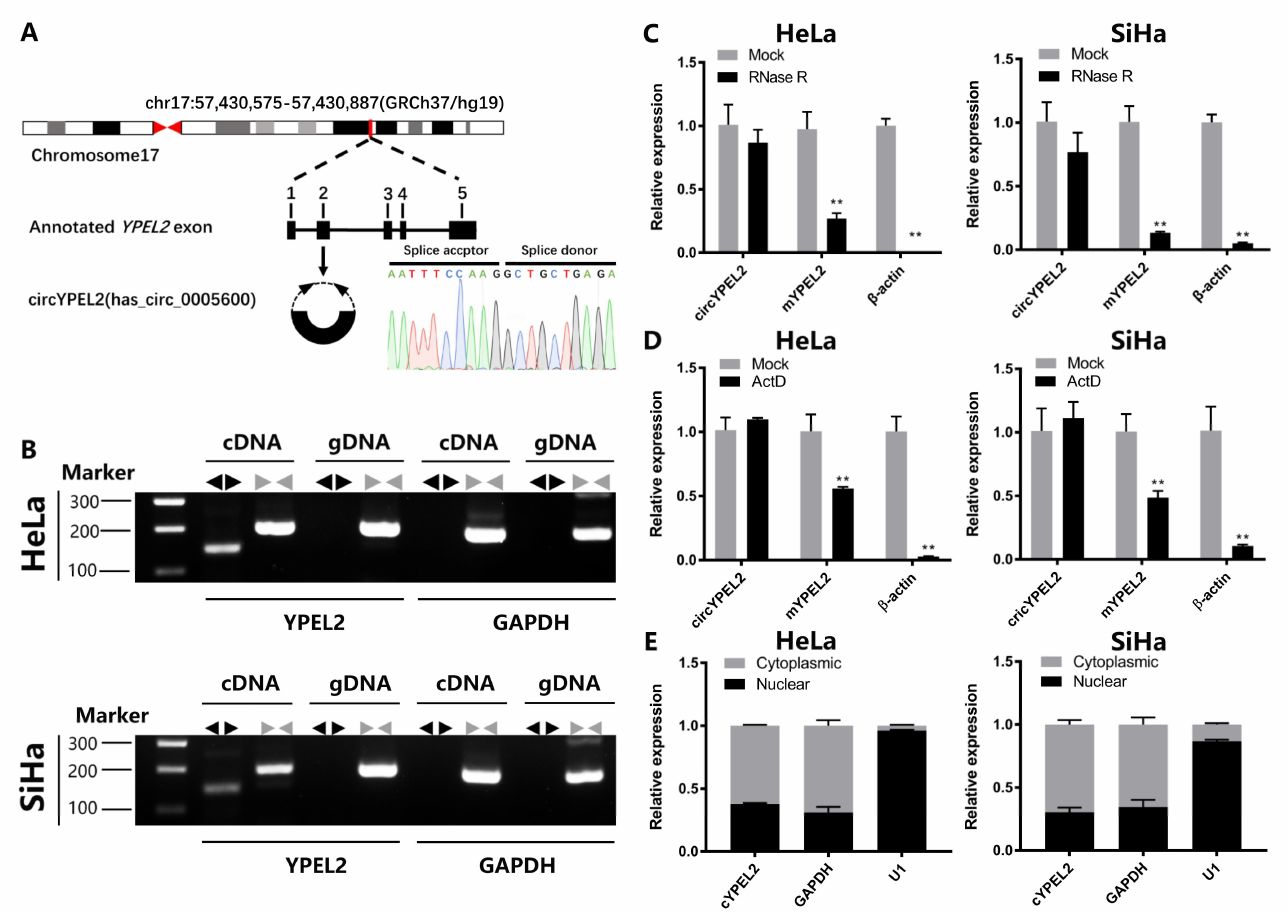
Figure 2. CircYPEL2 exhibits stability in CC cell lines. ( A ) Structures of the YPEL2 genome and transcript. CircYPEL2 is derived from exon 2. The back-splice junction of circYPEL2 was identi- fied by Sanger sequencing. ( B ) RT-PCR assay with divergent or convergent primers indicated the expression of circYPEL2 in HeLa and SiHa cell lines. GAPDH was used as negative control. The cDNA: complementary DNA; gDNA: genomic DNA. ( C ) The qRT-PCR analysis of the expression of circYPEL2 and YPEL2 mRNA after treatment with RNase R in HeLa and SiHa cell lines. ( D ) The qRT-PCR analysis of the expression of circYPEL2 and YPEL2 mRNA in response to treatment with actinomycin D for 24 h in HeLa and SiHa cell lines. ( E ) Fractionation experiments of cytoplasmic and nuclear mRNA showed that circYPEL2 localized in the nucleus and cytoplasm. β -actin and U1 were applied as positive controls in the cytoplasm and nucleus, respectively. (Mean ± SD of three experimental replicates are presented. ** Represents p <